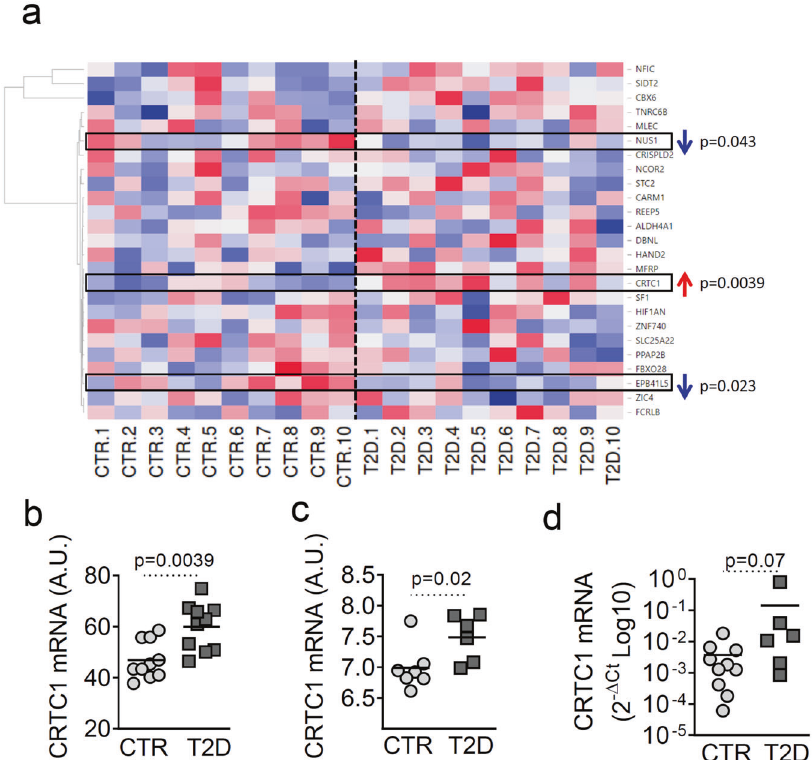
Fig. 2 CRTC1 is upregulated in LCM-captured human β -cells and in pancreatic islets from T2D donors. a Hierarchical clustering heatmap expression analysis of hsa-miR-184-3p predicted target genes ( n = 25) detected in LCM β -cells from n = 10 T2D vs. n = 10 non-diabetic donors (data previously published and deposited in GEO dataset GDS3782-GSE20966). Gene expression values are shown as arbitrary unit count (A.U.) values on a colour scale (high expression: red; low expression: blue). b Dot-plot diagram showing the CRTC1 expression values analysed in